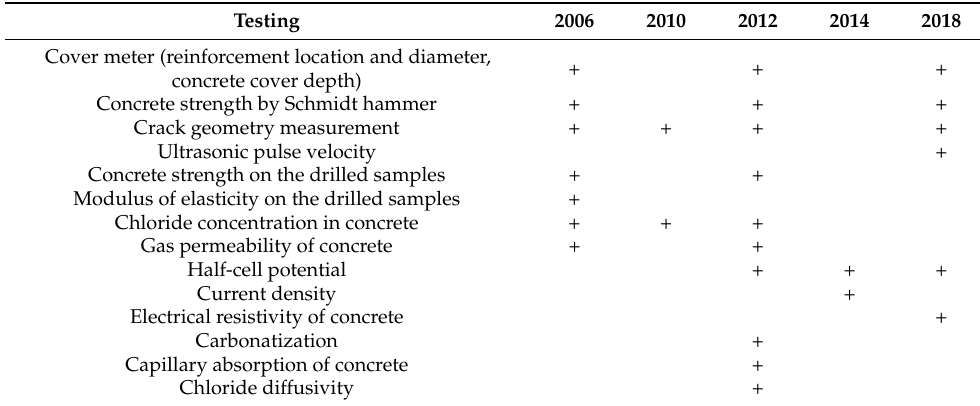
Table 3. List of testing carried out on the Maslenica Bridge from 2006 to